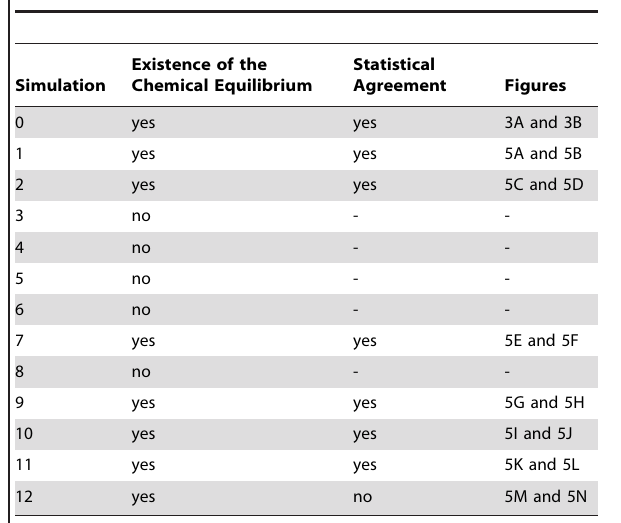
Table 2. Summary of the simulation results.